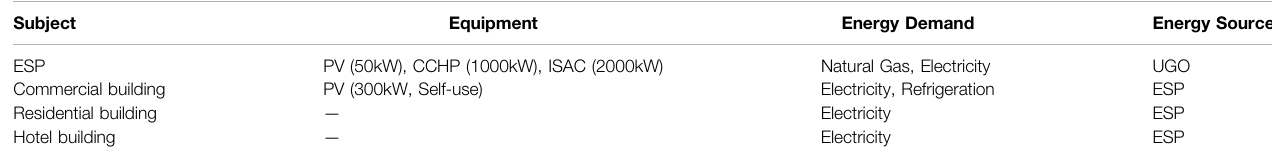
TABLE 3 | Equipment capacity and energy demand.